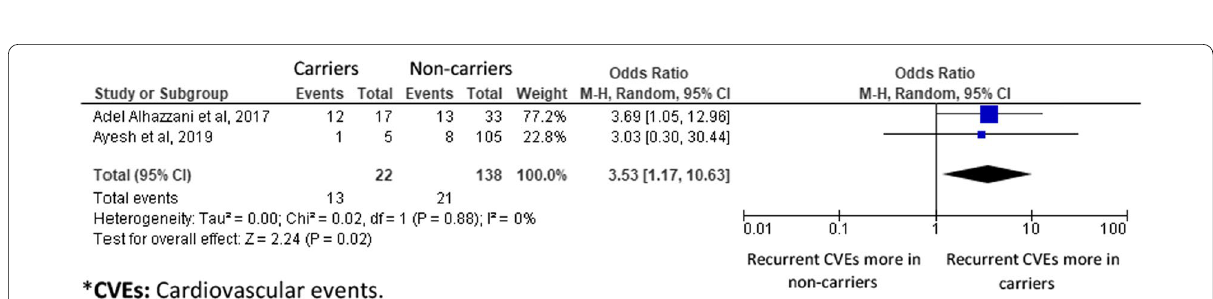
Fig. 3 Forest plot showing the frequency of recurrent CVEs among carriers and non-carriers of CYP2C19*3 mutation